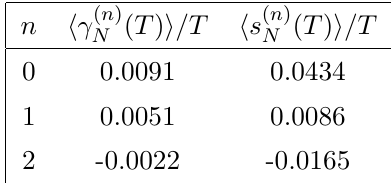
Table 1 . Coefficients in the momentum averaged rates at T = 10 6